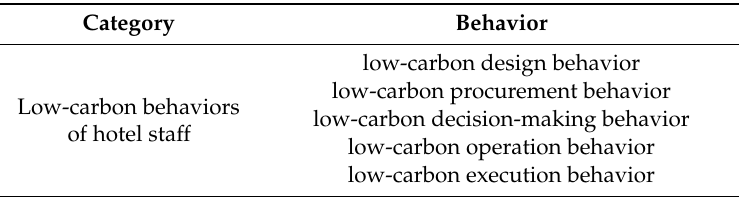
Table 1. Low-carbon behaviors of sta ff in star-rated